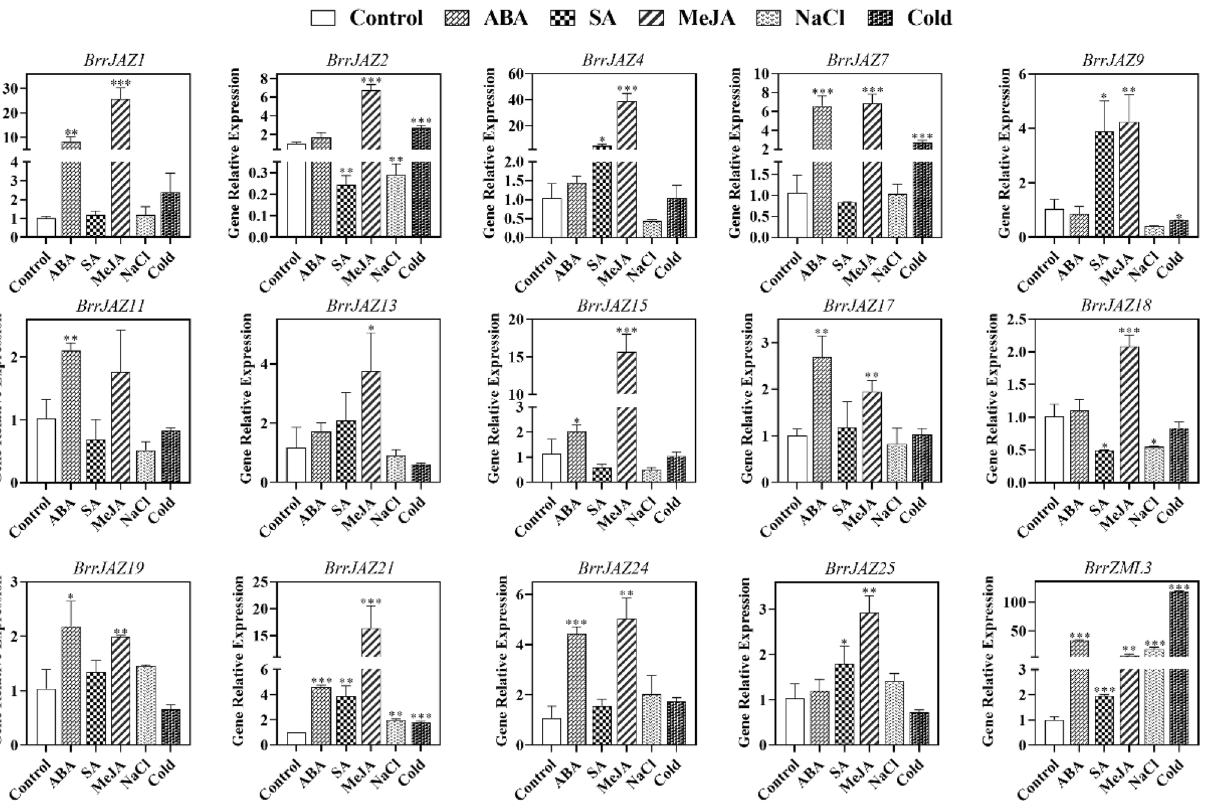
Figure 8. Expression of BrrJAZ family genes under abiotic stress and exogenous hormones. Error bars indicate standard deviation, and asterisks indicate significant differences between the control and treatments, * P < 0.05, ** P < 0.01, *** P <